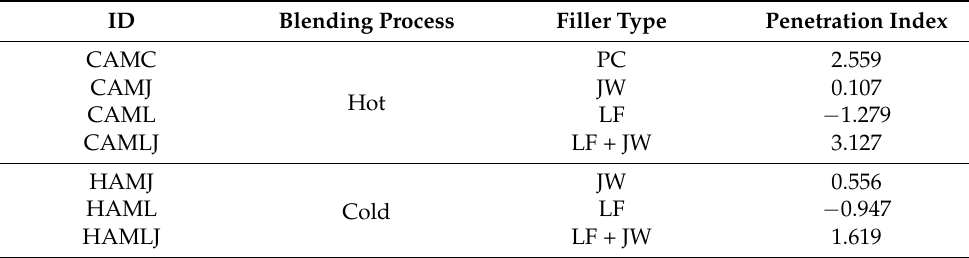
Table 4. Penetration index values of the asphalt